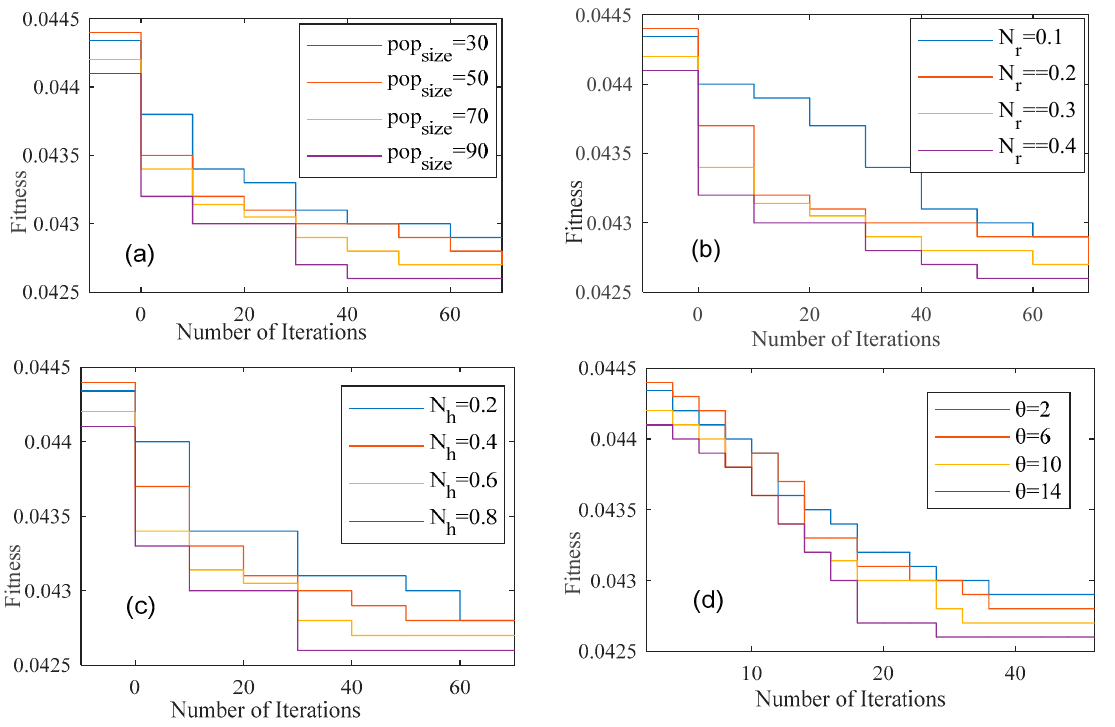
Figure 4. Optimization performance of HIOA over iterations ( a ) pop size ( b ) N r ( c ) N h ( d ) θ